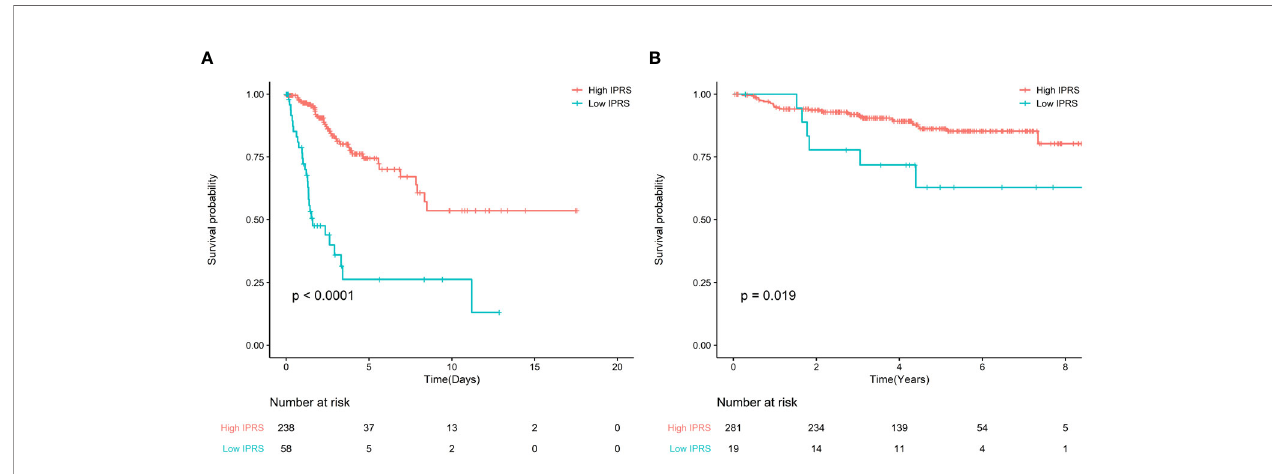
FIGURE 2 | (A) Survival curve of OS between high IRPS and low IRPS in TCGA; (B) Survival curve of FPS between high IRPS and low IRPS in